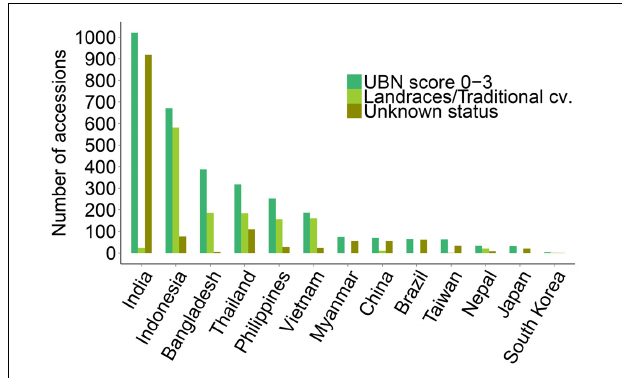
FIGURE 2 | Landraces/traditional cultivars among identified resistant rice genotypes. Landraces/traditional cultivars among the blast resistant genotypes from the respective countries are shown, together with the resistant genotypes of unknown status. India contributes nearly one third of the total blast resistant genotypes but 90% of the accessions have an unknown sample status. Excluding India, 60% of the blast resistant rice genotypes identified in the 12 remaining countries are traditional cultivars/landraces. None of the resistant accessions from Myanmar, Brazil and Japan were landraces/traditional cultivars but a large numbers of identified resistant cultivars from these countries have an unknown status as well. A minor proportion of the UBN-resistant genotypes were inbred lines and improved varieties (data not shown).